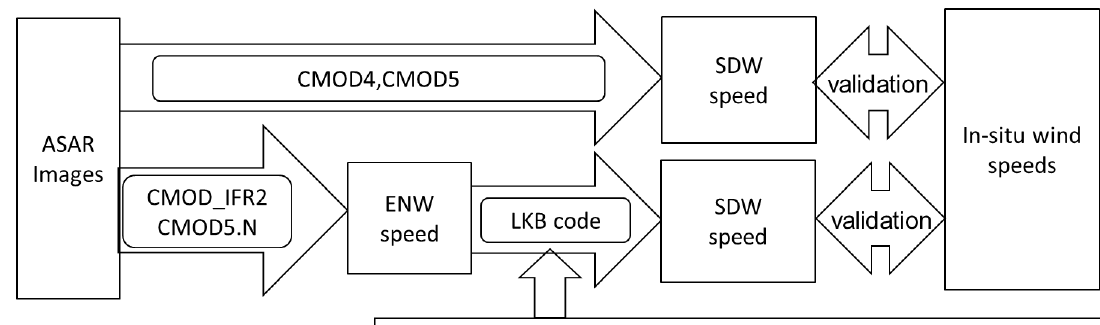
Figure 2. Flowchart of wind retrieval from an Advanced SAR image and validation with in situ wind